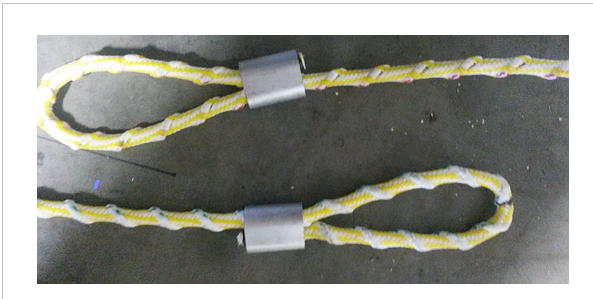
FIGURE 1 Helix twine sections for the OBT with markings delineating the direction of coils, clockwise (red markings; top) and counterclockwise (green markings;